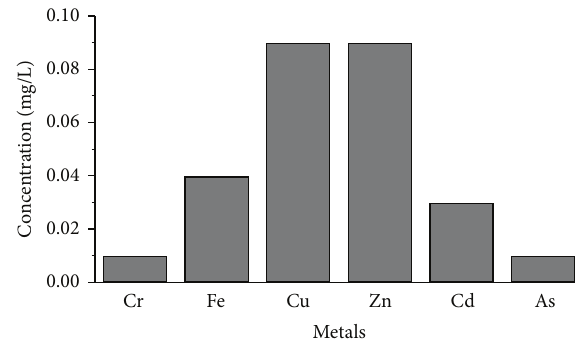
Figure 4: Metal concentrations after lime